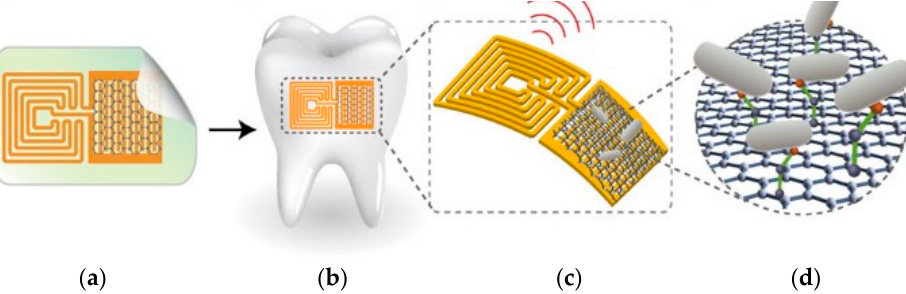
Figure 9. Biotransferrable graphene wireless biosensor. ( a ) Graphene is printed onto bioresorbable silk, and contacts are formed containing a wireless coil; ( b ) biotransfer of the nanosensing architecture onto the surface of a tooth; ( c ) magnified schematic of the sensing element, illustrating wireless readout; and ( d ) binding of pathogenic bacteria by peptides self-assembled on the graphene nano-transducer (reprinted with permission from [79]).